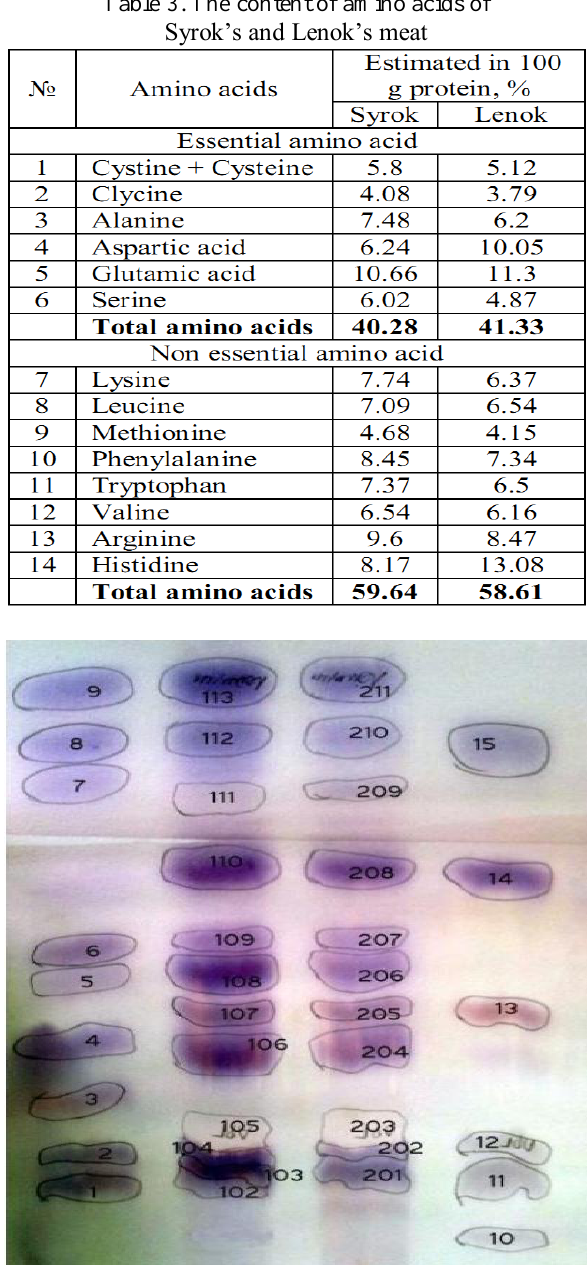
Table 3. The content of amino acids of Syrok’s and Lenok’s meat